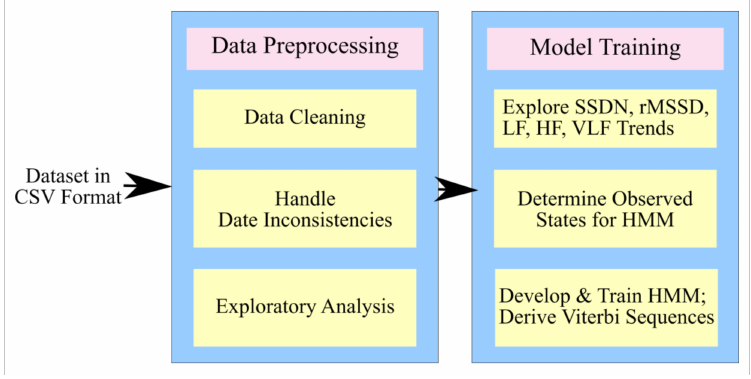
Figure 2. The architecture of the proposed